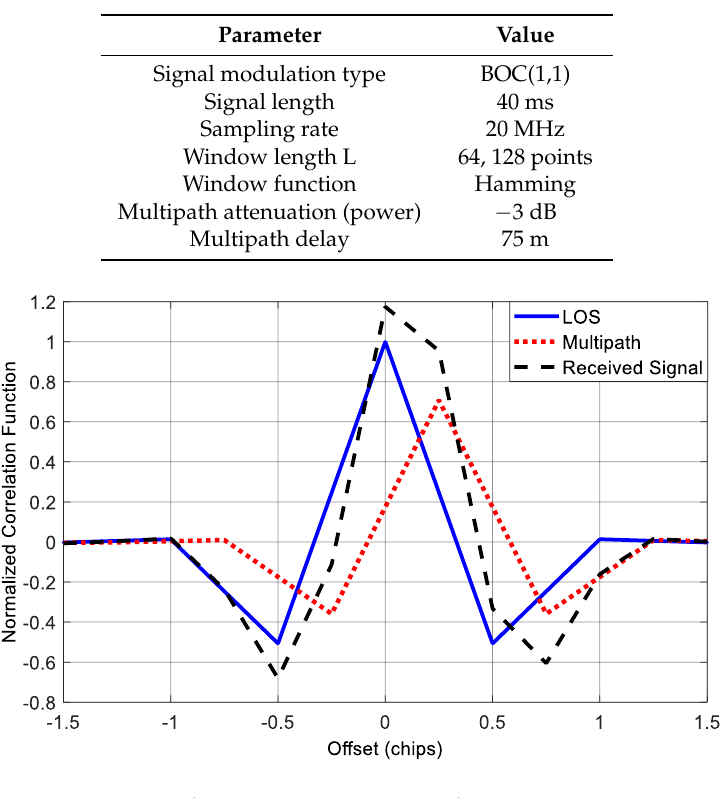
Figure 10. Correlation functions in the presence of single multipath component.